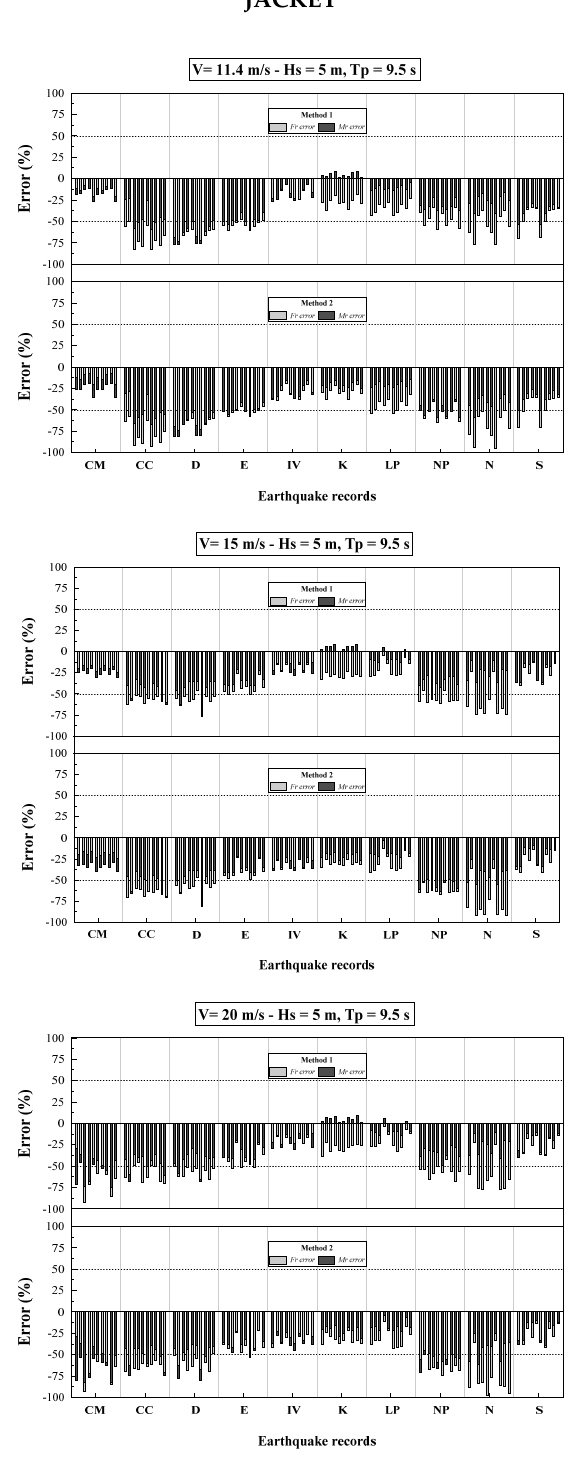
Figure 4. Jacket: Tower base errors (18) and (19) obtained by Methods 1 ‐ 2 for sea state parameters H s = 5 m, T p = 9.5 s, all wind velocities and earthquake records listed in Table 3.